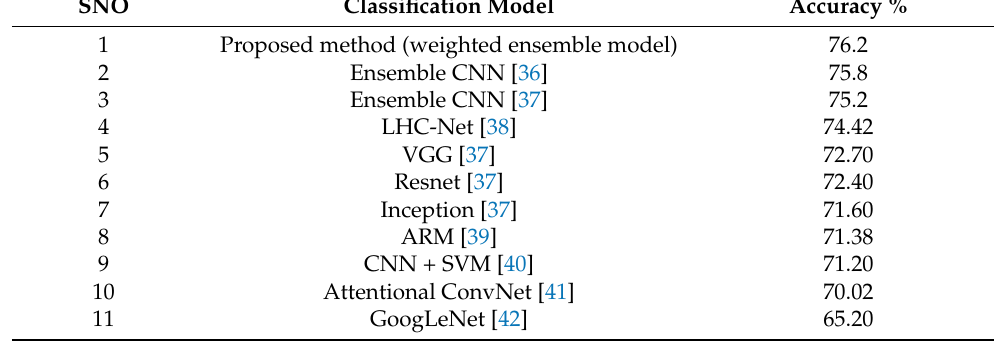
Table 1. Classification accuracy on the FER-2013 dataset.